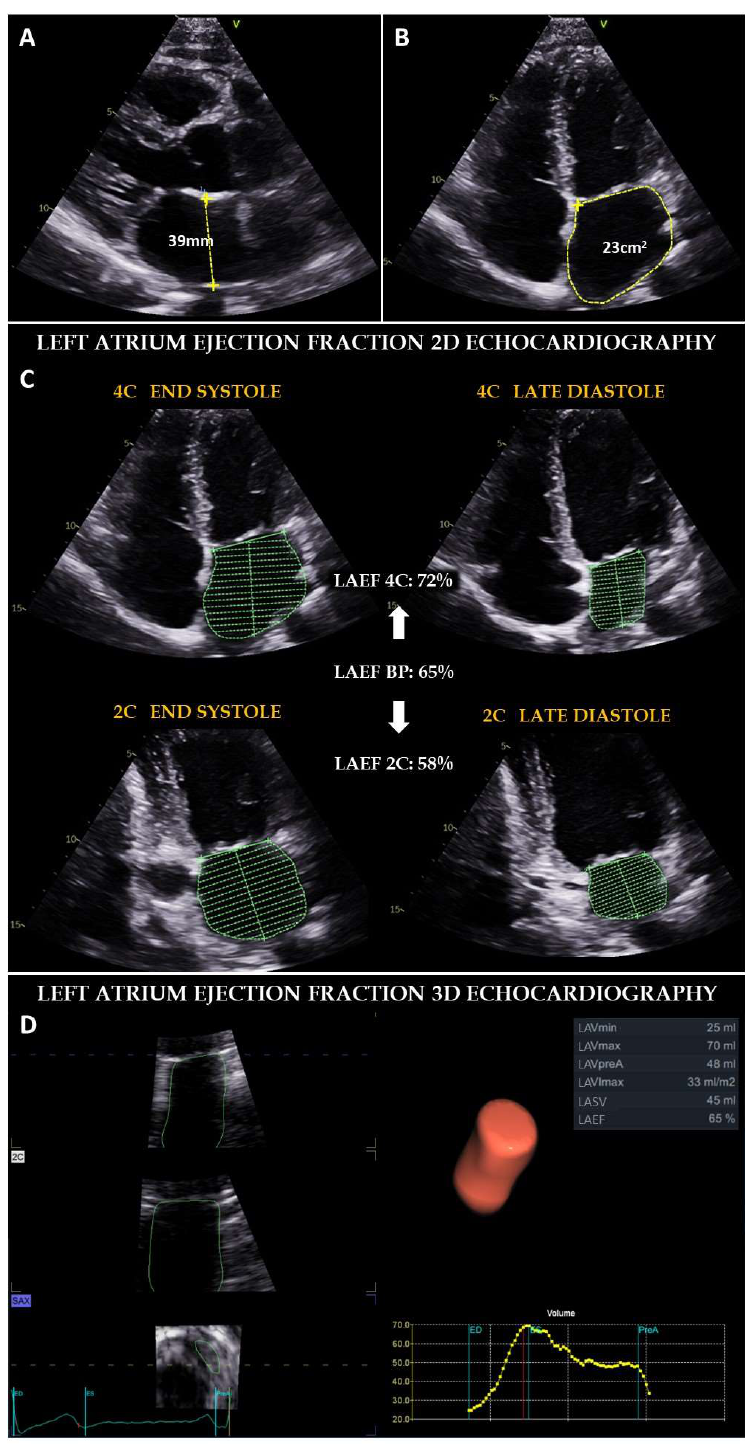
Figure 3. Methods for the determination of LA size and function by performing TTE. ( A ) Maximal anteroposterior LA diameter measured in 2 dimensions in parasternal long axis view from leading edge to leading edge, perpendicular to the posterior wall of LA. ( B ) Maximal LA area measured in apical four chamber view. ( C ) Total LA ejection fraction calculated by 2 dimensions in four and two chamber apical view. Maximum volume is assessed in end systole just before mitral valve opening. Minimum volume is estimated in late diastole in the onset of the P wave. ( D ) Total LA ejection fraction measured in 3 dimensions, acquiring a complete volume including the LA and applying specific software for the